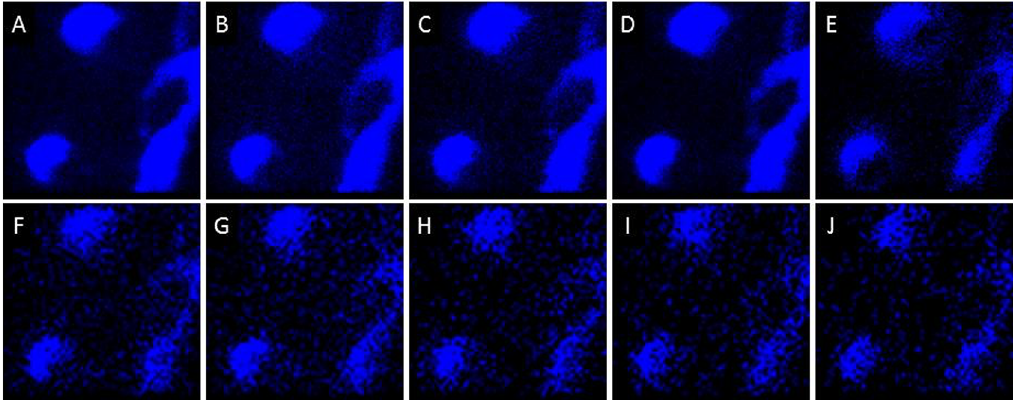
Figure 4. Distribution of additional ions in the 40 (cid:1) 40 μ m field of view in Figure 3 from the tridimensional analysisusingBAmodeat m/z A)125,B)147,C)166,D)184,E)224,F)518,G)520,H)740,I)742,andJ)908. Images F-J are binned x4 for clarity. Data are representative of 3 independent